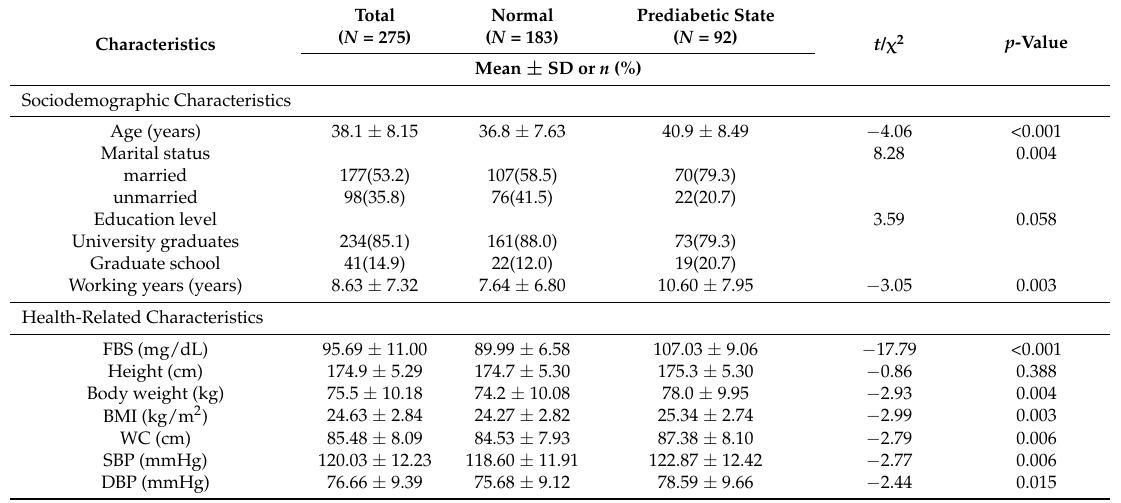
Table 1. Sociodemographic and Health-Related Characteristics in the Study Population.